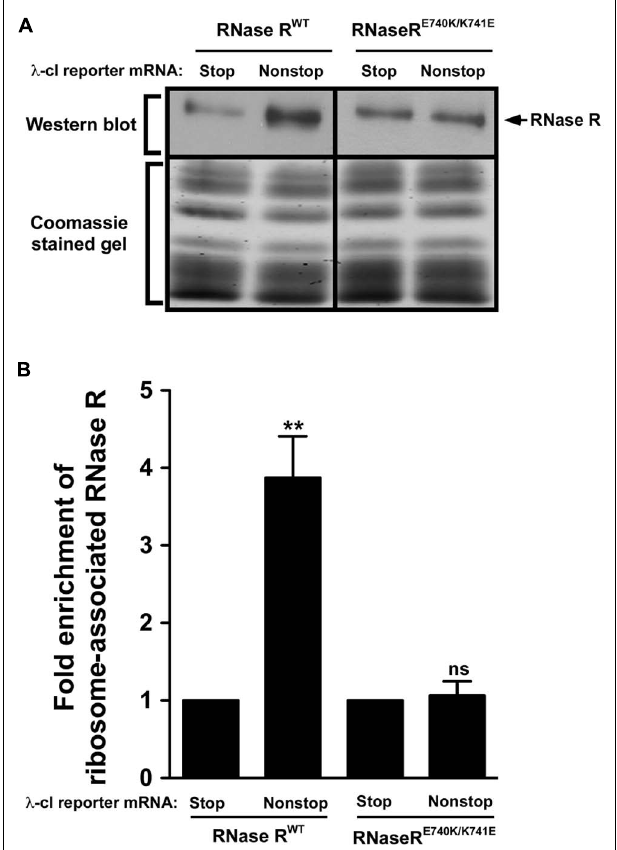
FIGURE 7 | Swapping of residues E740 and K741 renders RNase R defective in enrichment on stalled ribosomes. (A) Enriched ribosomes were obtained from cells co-expressing RNase R WT or the RNase R E740K / K741E switch variant with either the λ -cI-S or λ -cI-NS reporter mRNA.Western blot analyses were performed as described in Figure 6 . Intensities of the bands were quantified using ImageJ.The top panel shows a representativeWestern blot, using an RNase R specific antibody, and the bottom panel shows a section of the corresponding Coomassie stained gel displaying equal protein loading. (B) The graph represents fold enrichment of RNase R on stalled ribosomes compared to its corresponding background level with the control λ -cI-S reporter.The data are representative of three independent experiments (MEAN ± SEM). P -values were calculated by performing student’s t -test analysis on the association level of RNase R WT and RNase R E 740 K / K 741 E (** P < 0.008) on stalled ribosomes translating λ -cI-NS reporter. ns = not statistically